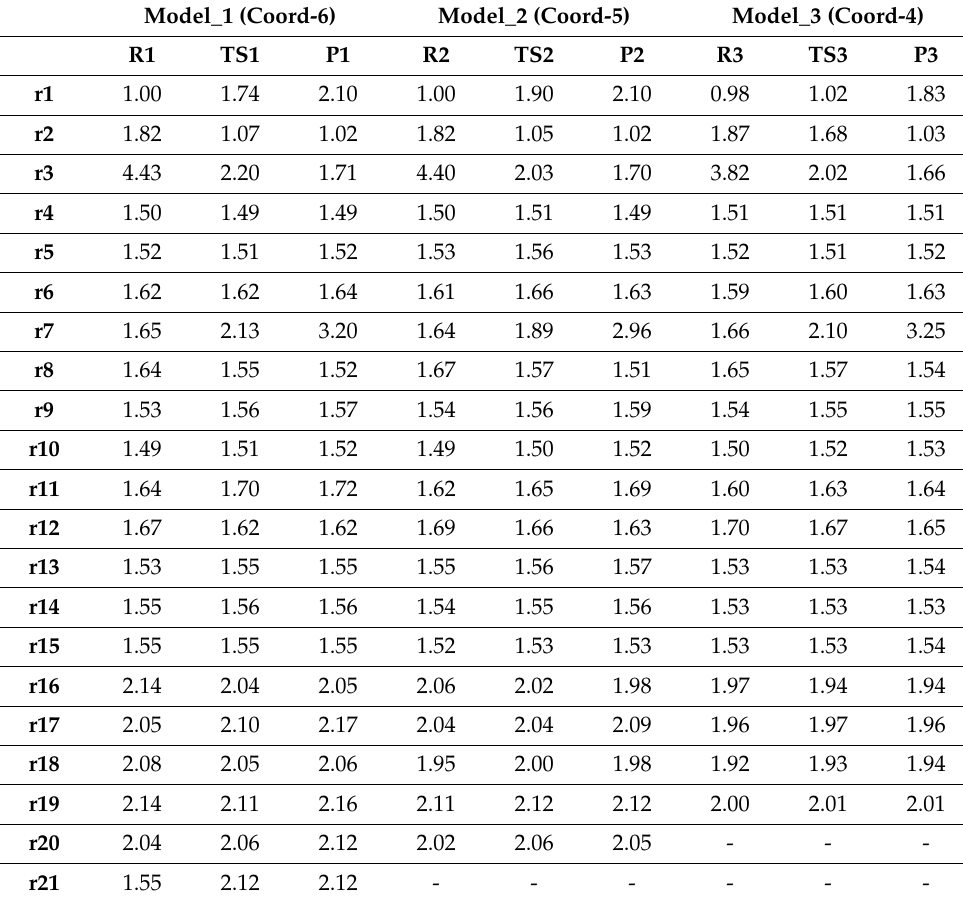
Table 1. Important bond lengths (angstrom) in reactant, transition state and product of AMPylated reaction. r1, r2, r3 and r7 are the dominant reactive bond. r16, r17, r18, r19, r20 and r21 are coordinated bonds. (denoted in Figure